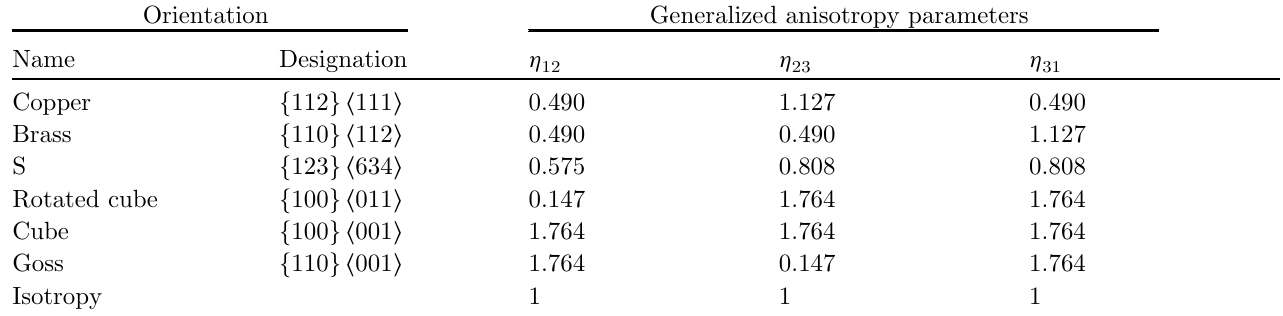
Table 3. Crystallographic orientations and their parameters.